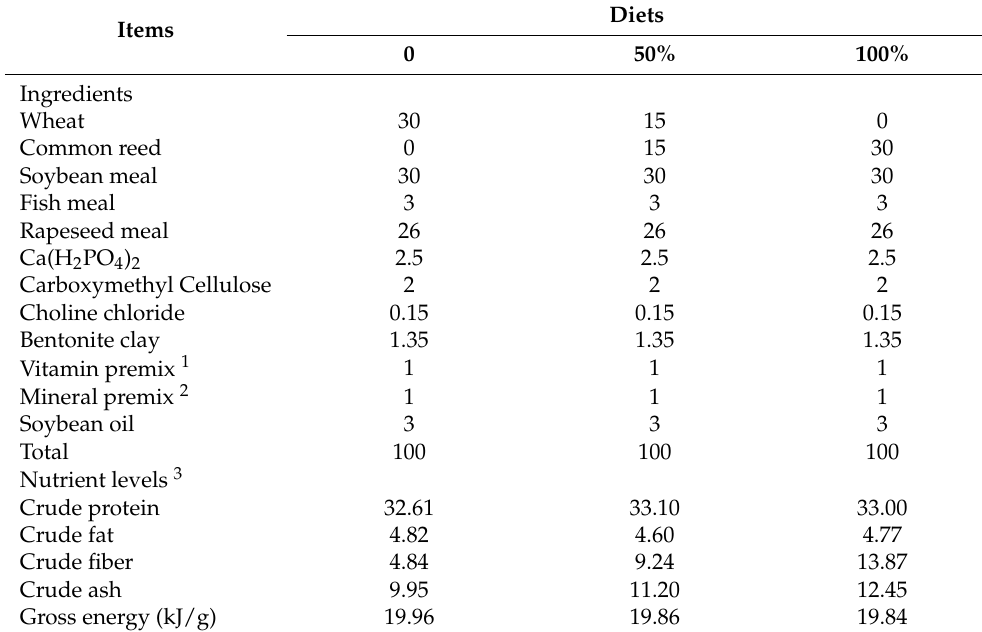
Table 2. Composition and nutrient levels of experimental diets (dry matter